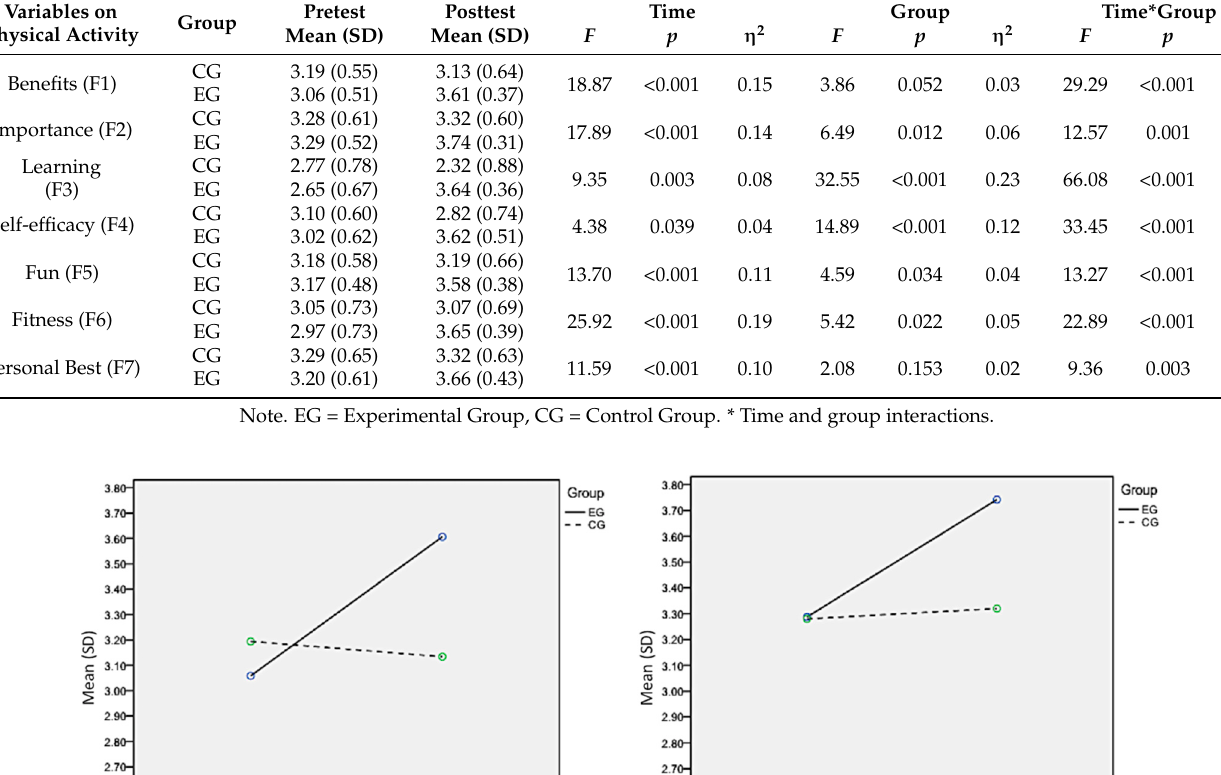
p = 0.04) (Figure 2). Table 3. Descriptive Statistics and ANOVA at pre-test/post-test for students in the Experimental Group (EG; n = 48) and Control Group (CG; n = 65).